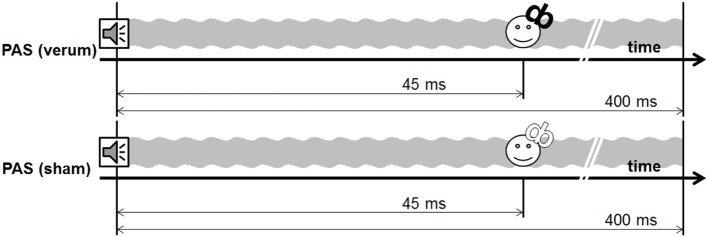
Design experiment 2.